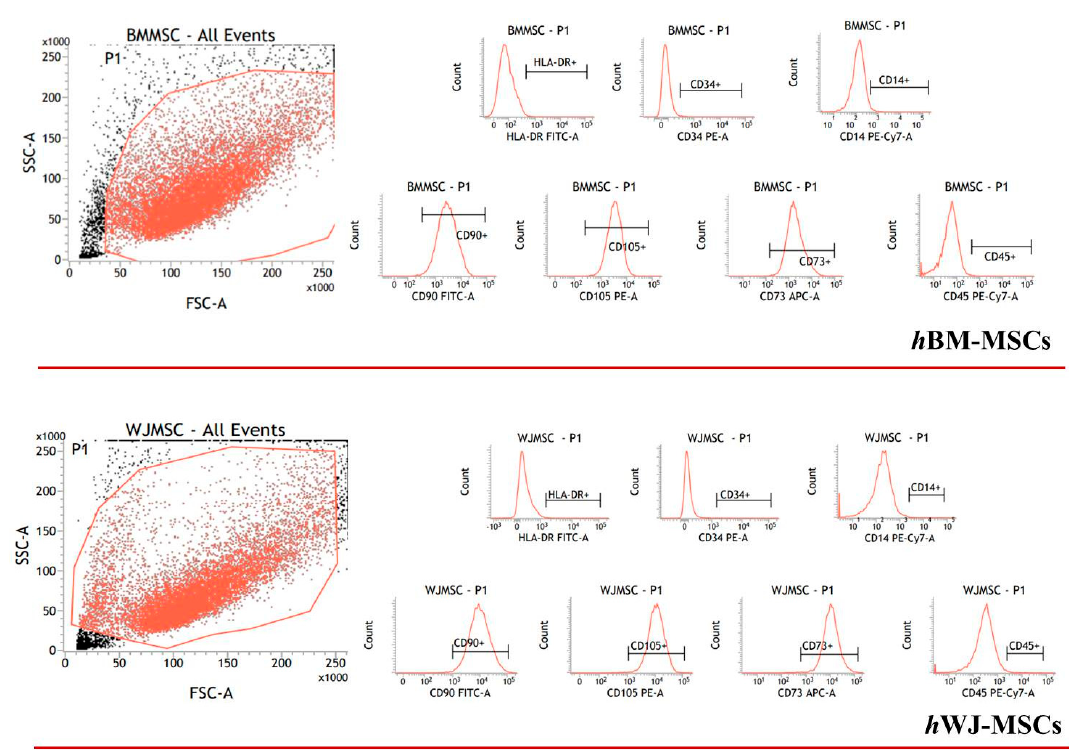
Figure 1. Flow cytometry events illustrate human bone marrow mesenchymal stem cells (hBM-MSCs) and human Wharton’s Jelly mesenchymal stem cells (hWJ-MSCs) characterization. The panel shows the representative flow cytometry event of forward scatter (FSC) vs. side scatter (SSC).